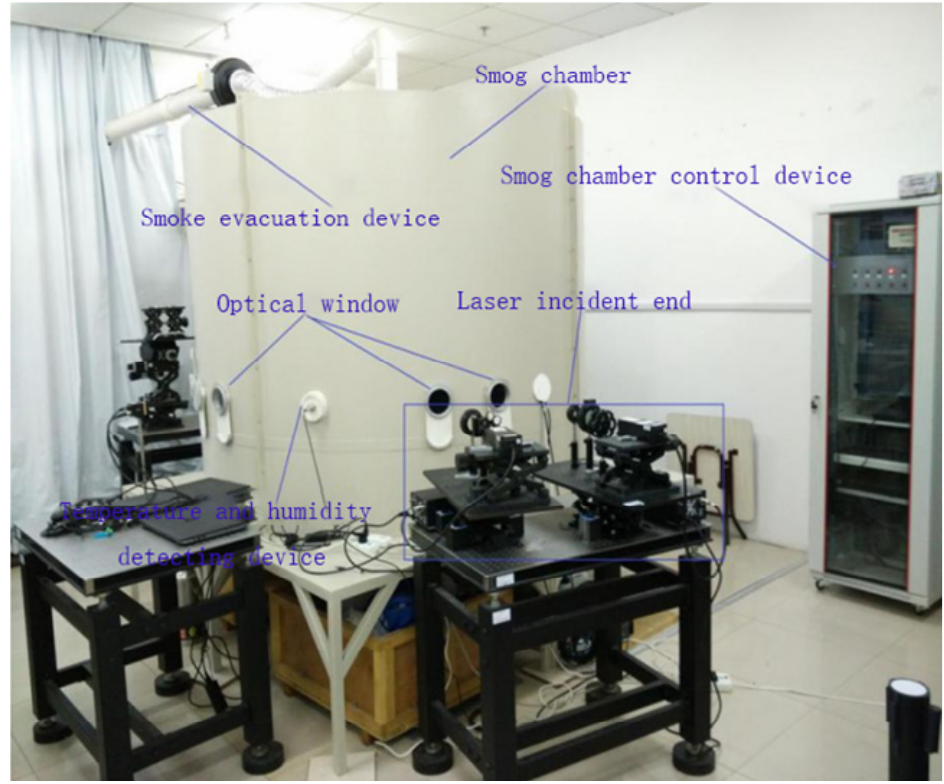
Figure 4. A physical representation of the polarization transmission characteristic test setup.